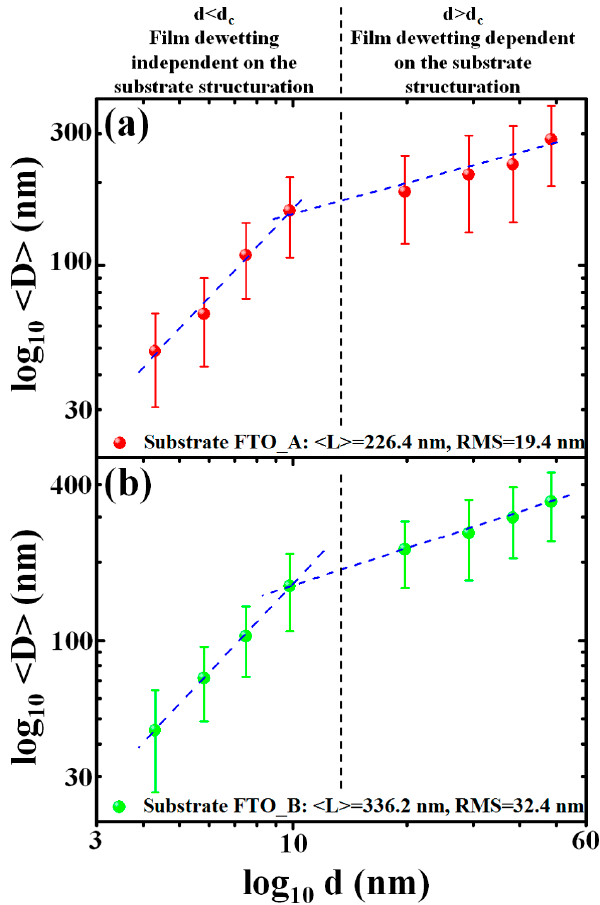
Figure 11. Log-Log plots of the nanoparticles mean diameter < D > as a function of the starting thickness d of deposited AuPd film on the untreated FTO (substrate A, ( a )) and on the textured FTO (substrate B, ( b